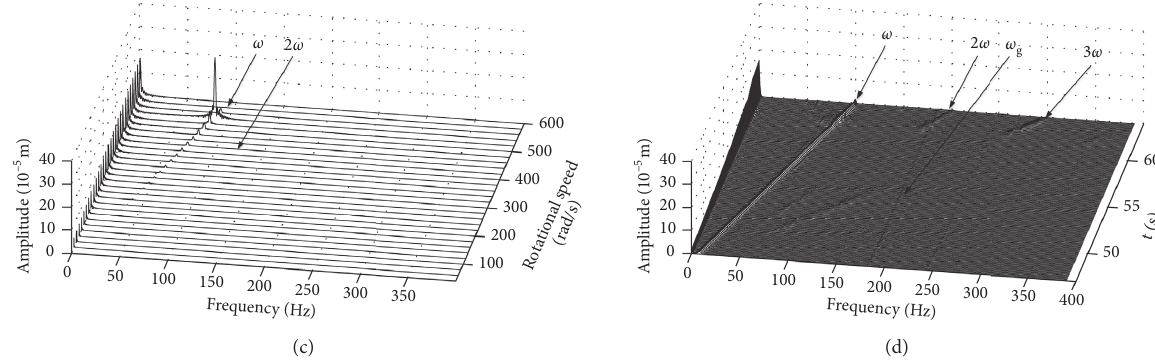
Figure 10: Waterfall spectra plots for the vibration of disk 3 during the synthetic maneuver of hovering and rolling. (a) Horizontal response, numerical simulation. (b) Horizontal response, experimental results. (c) Vertical response, numerical simulation. (d) Vertical response, experimental